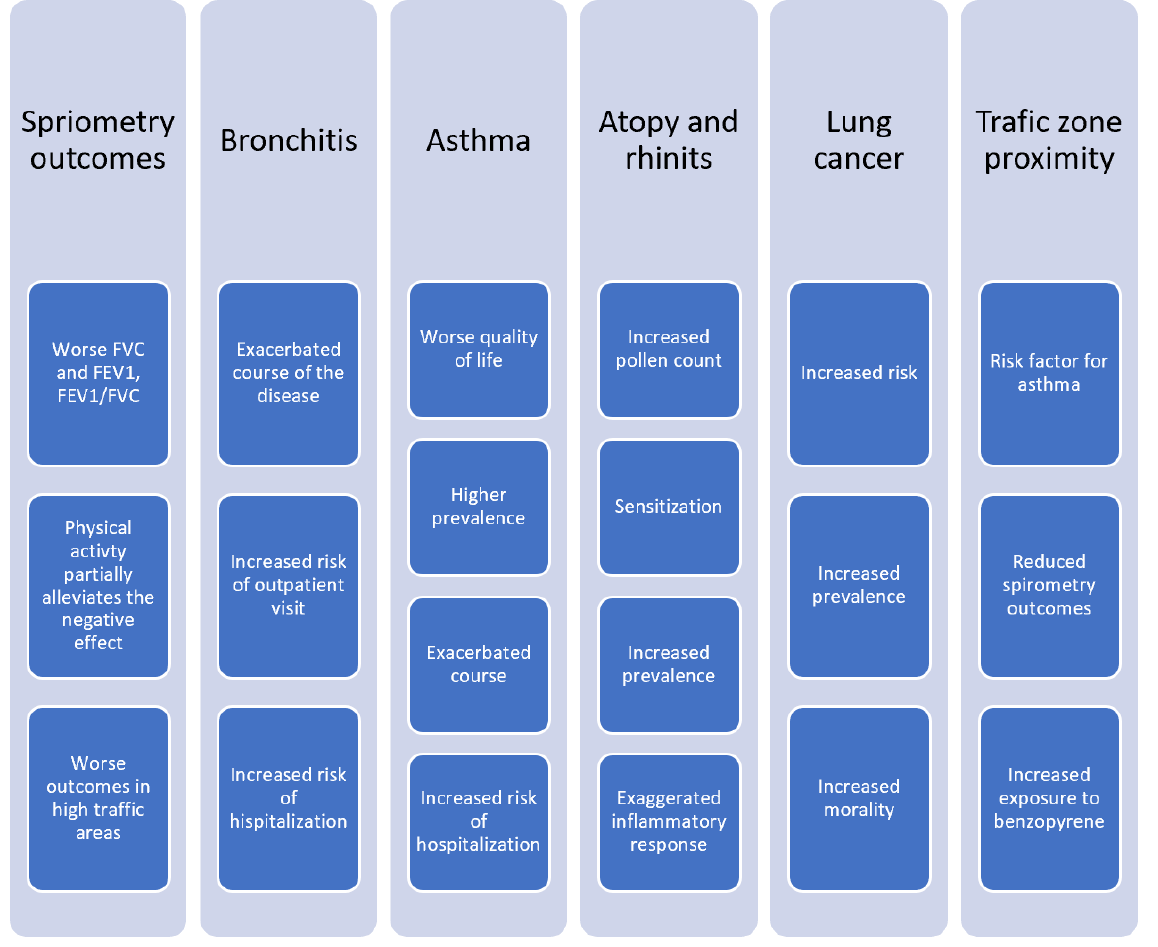
Figure 6. Effect of air pollution on ad ults’ health.